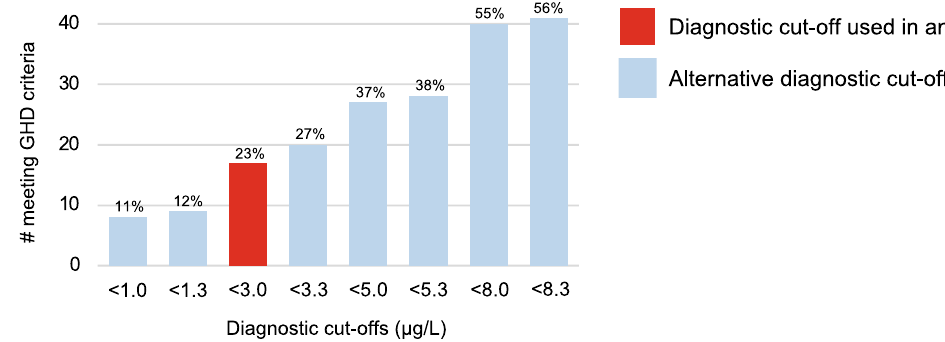
Figure 2. GHD prevalence using alternative diagnostic cut-offs based on peak GH during dynamic testing. Numbers of patients meeting differential diagnostic cut-offs with percentages calculated out of total number of individuals tested (n = 73). GH growth hormone, GHD growth hormone deficiency.